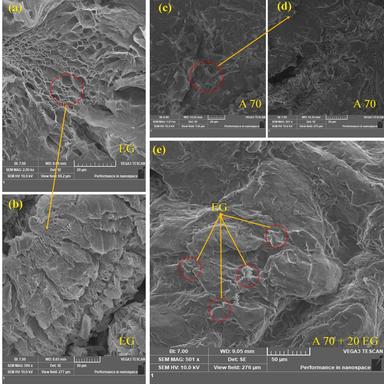
Structural analysis of SS-PCM composites. SEM images of (a) EG-20um, (b) EG-50um, (c) A70-20um (d) A70-50um and (e) A70 + 20EG SS-PCM composite-50um.